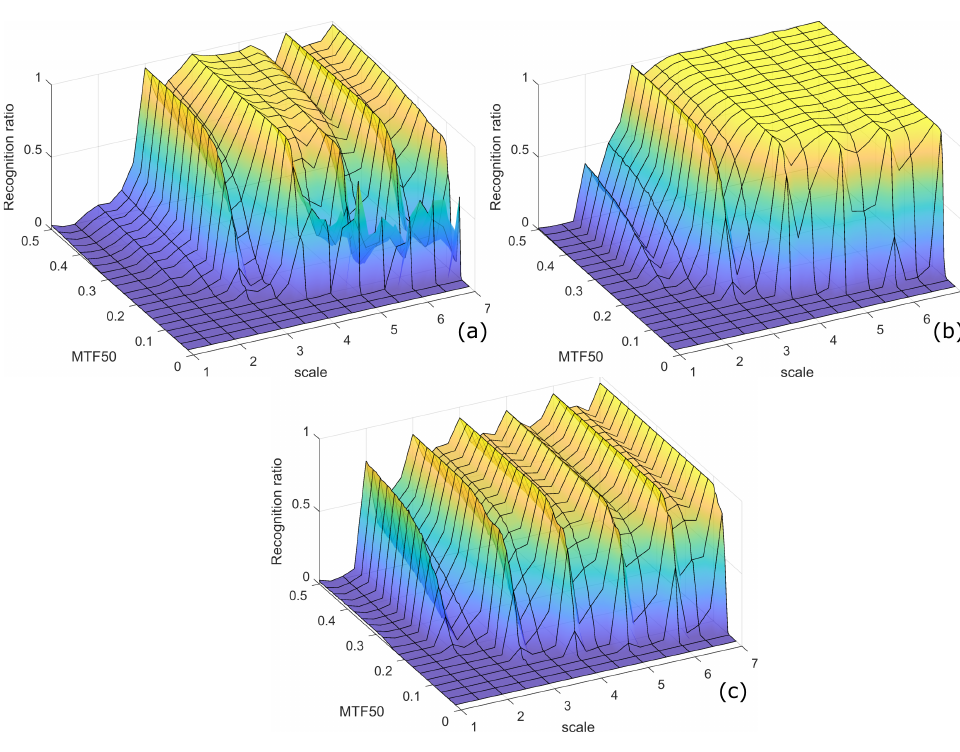
Figure 11. Recognition ratio for QR code image decoding for: ( a ) ZXing, ( b ) ZBar, ( c ) OpenCV.